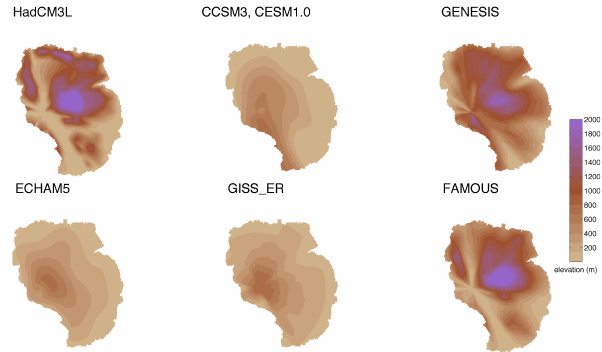
Fig. 6. Bedrock elevation maps, shown is the surface topography from the different GCM simulations for East Antarctica, compare with the ISM surface topography in Fig. 1. Note the significantly lower elevation of the CCSM3, CESM1.0, ECHAM5 and GISS ER simulations